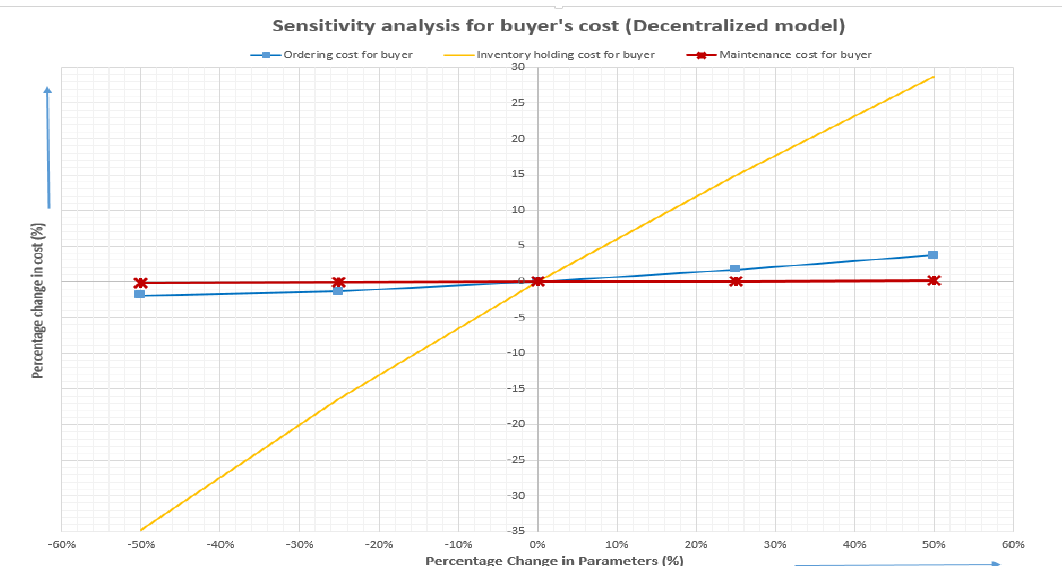
Figure 6. Sensitivity analysis: buyer’s cost versus change in parameters under decentralized model.